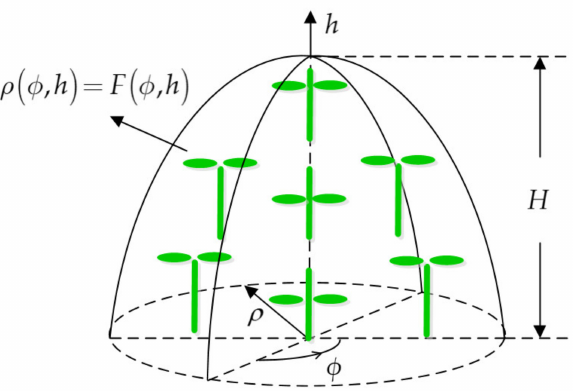
Figure 2. Tridimensional geometry representation of the ideal crown shape in the cylindrical coor- dinate system ( ρ , φ , h ) , where an ellipse represents a leaf, and a cylinder represents a branch; H is crown height, and ρ ( φ , h ) = F ( φ , h ) is the crown envelope